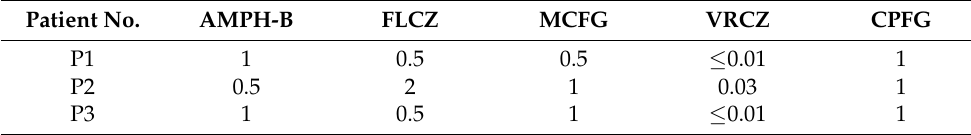
Table 2. Antifungal agent susceptibility profiles (minimum inhibitory concentrations, mg/L). Patient